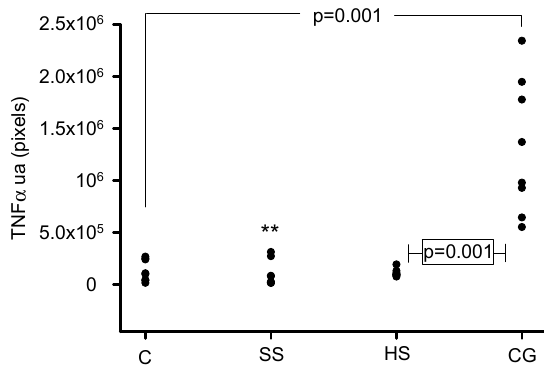
Figure 9. Densitometric analysis for the marker TNF α in the glomeruli from the experimental groups. The TNF α antibody was negative for the C, SS and HS vs. CG groups; ** SS vs.CG, p = 0.006. Abbreviations: C = control, SS = saline solution, HS = healthy subjects and CG = collapsing glomerulopathy ( n = 6). Each point is the mean of the analysis of 5 glomeruli per group.